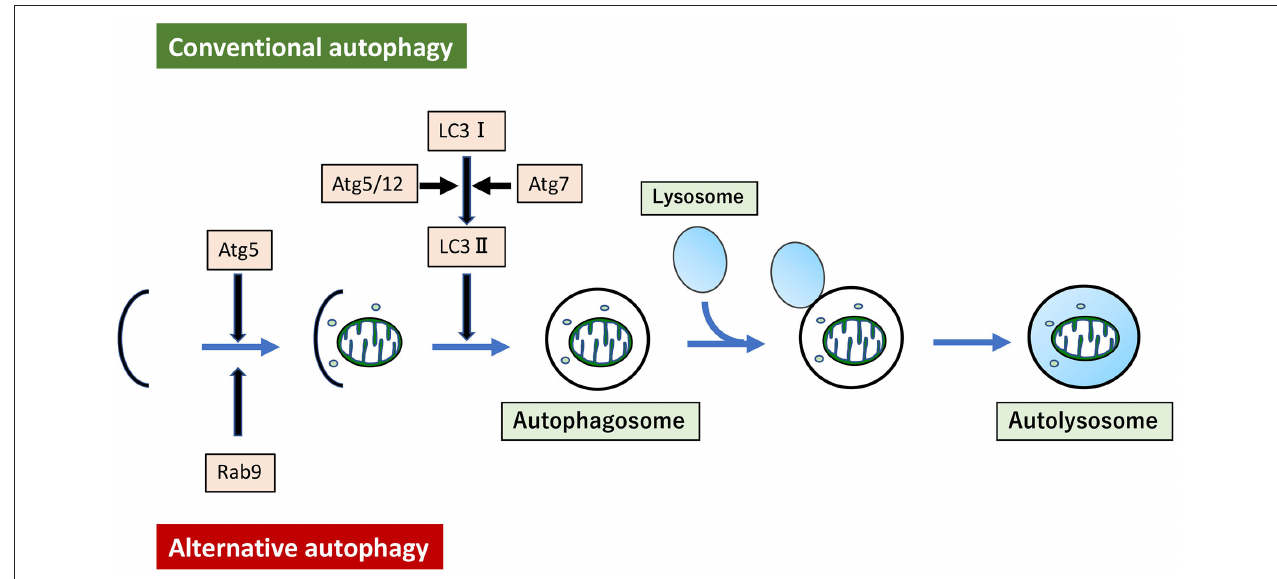
FIGURE 3 | Conventional autophagy and Alternative autophagy. Mitophagy arises from two forms of autophagy. One is LC3-dependent conventional autophagy, which requires Atg5/Atg7, and the other is LC3-independent, membrane trafficking protein Rab9-dependent alternative autophagy.